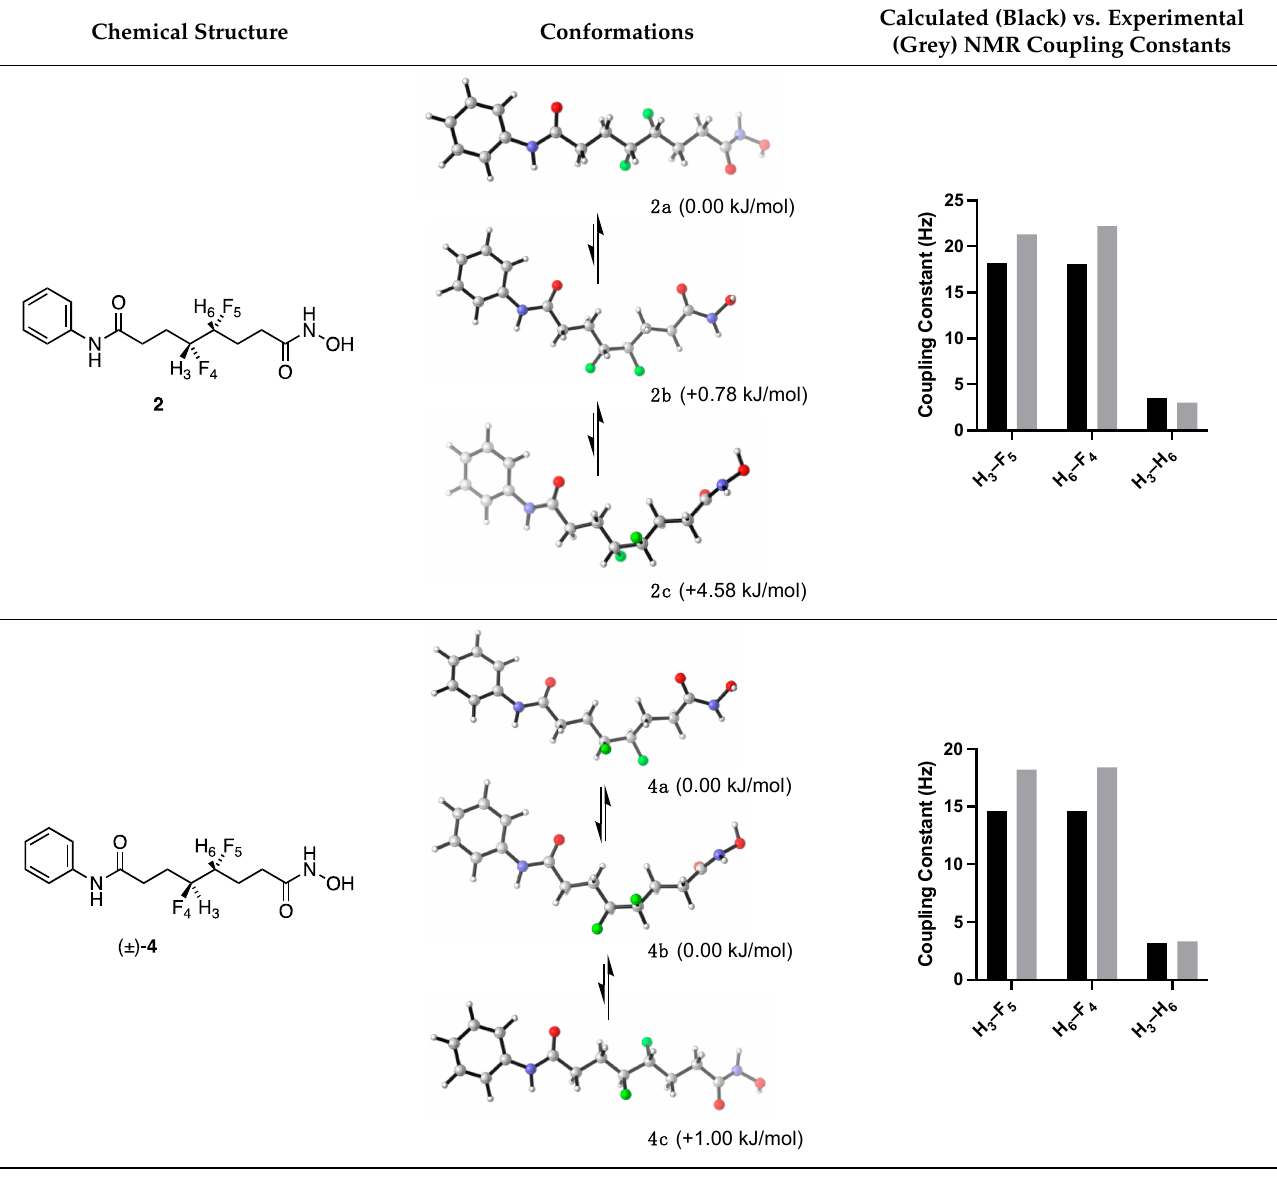
Table 1. Conformational analysis of 2 – 4 and 8 – 9 .